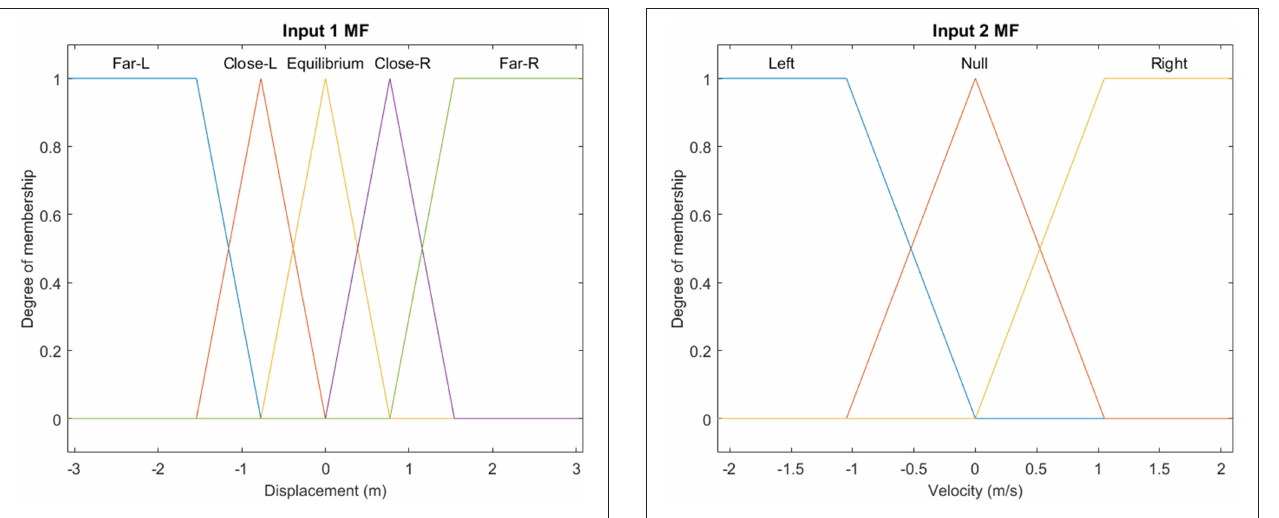
FIGURE 3 | Membership functions of input 2 (velocity) of the fuzzy controller.